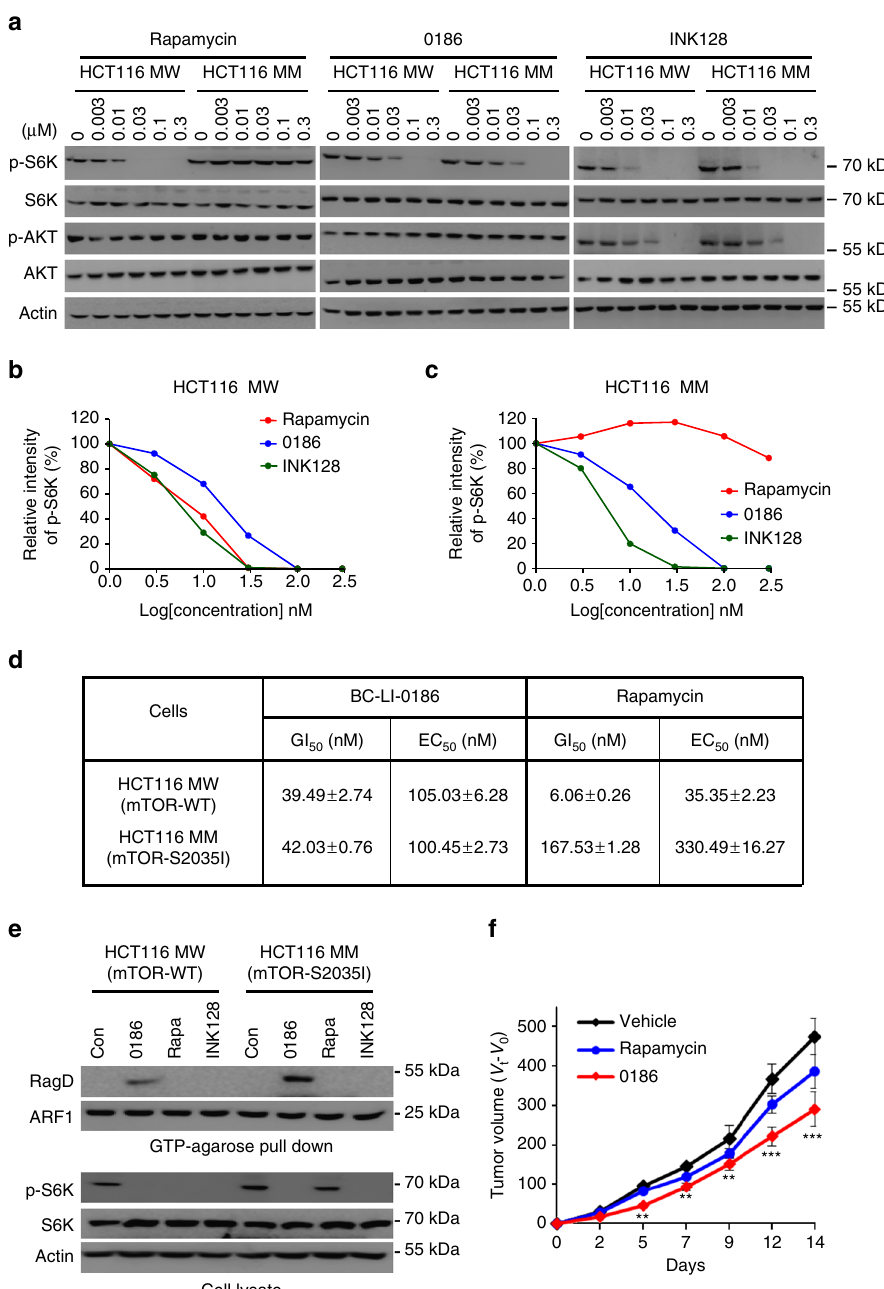
Fig. 7 Ef fi cacy of BC-LI-0186 to rapamycin-resistant cancer cells. a HCT116 MW (mTOR WT) and MM (mTOR S2035I) cells were treated with rapamycin, BC-LI-0186, and INK128 at the indicated concentrations (nM) for 6 h. The cell lysates were subjected to immunoblotting analysis with anti-mTOR, anti-p- S6K, anti-S6K, and anti-actin antibodies. b The level of p-S6K in HCT MW cells shown in a was quanti fi ed and displayed as graph. c The level of p-S6K in HCT MM cells shown in a was quanti fi ed and displayed as graph. d Cell growth GI 50 and cell death EC 50 values of BC-LI-0186 and rapamycin against HCT116 MW and MM cells. e GTP-agarose bead pull-down assays were used to monitor the GTP-bound RagD in HCT116 MW and MM cells. After cells were treated with 10 μ M BC-LI-0186, 100 nM rapamycin, or 10 μ M INK128, the cell lysates were incubated with GTP-agarose beads and the proteins precipitated with the beads were analyzed by immunoblotting with anti-RagD or anti-ARF1 antibodies. f HCT116 MM cells were injected subcutaneously to nude mice. BC-LI-0186 and rapamycin were intraperitoneally administered into the mice at the indicated doses every day ( n /group = 6). Tumor volume was measured every other day for 2 weeks. The error bars represent mean ± S.D. * p < 0.05; ** p < 0.01; *** p < 0.001 (vs.